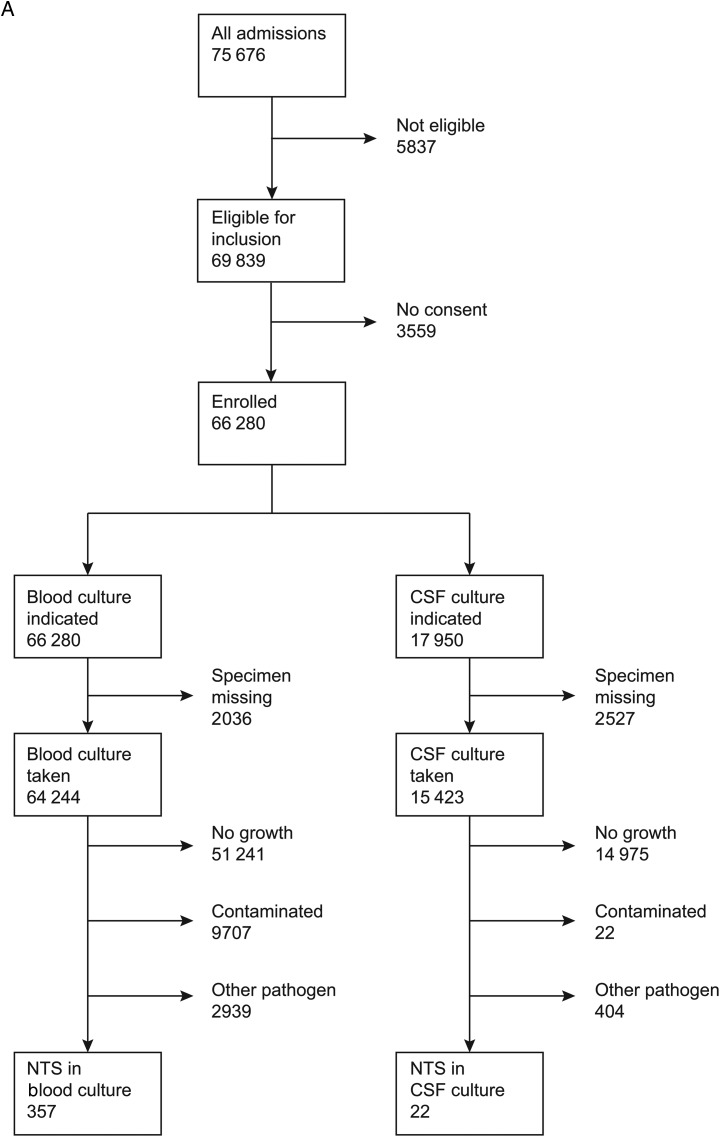
Consolidated Standards of Reporting Trials (CONSORT) diagram representing flow of patients. A, Children. B, Adults. Abbreviations: CSF, cerebrospinal fluid; NTS, nontyphoidal Salmonella.